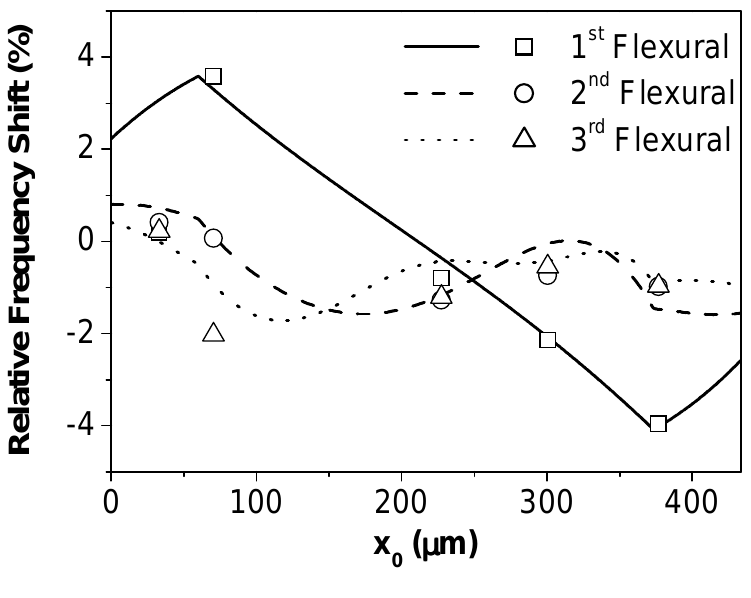
Figure 2. Experimental measurements of the resonance frequency shift as a function of the longitudinal position of the adsorbed bacteria with respect to the clamping for the first (open squares), second (open circles) and third (open triangles) flexural modes. The lines represent the theoretical calculations for the first (solid), second (dash) and third (dotted) flexural